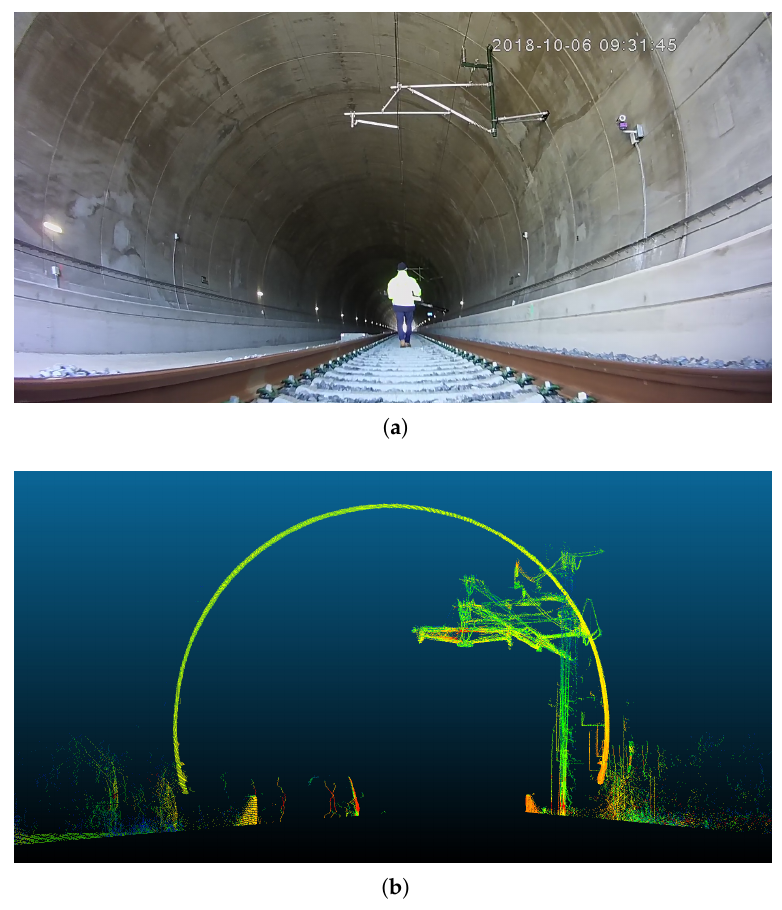
Figure 7. Real tunnel railway environment in which real environment data was collected. ( a ): picture from real environment; ( b ): point cloud recorded in the real